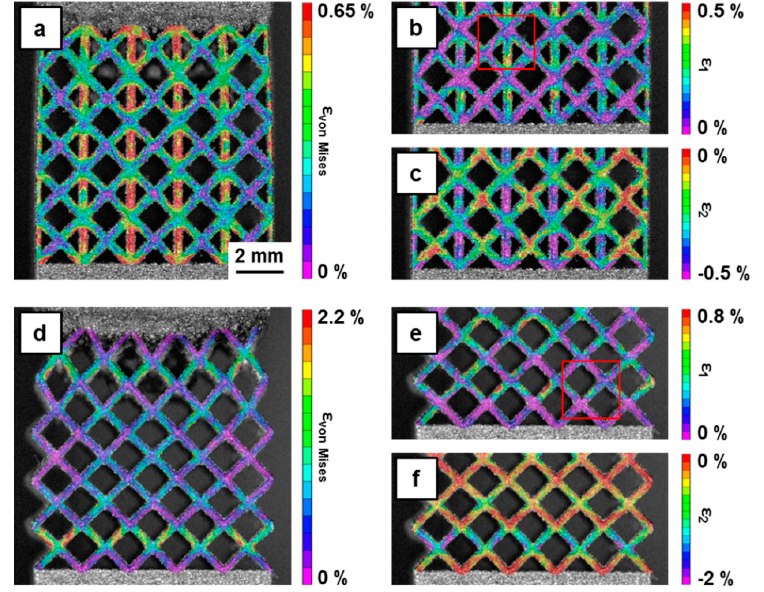
Figure 7. Local strain plots for ( a – c ) f2ccz and ( d – f ) bcc 316L lattice structures as obtained by DIC at a macroscopic strain of 1%. ( a , d ) depict distribution of local Von-Mises strains; ( b – f ) highlight maximal and minimal principle strains, respectively—recompiled from [35]. Metals 2020 , 10 , x FOR PEER REVIEW